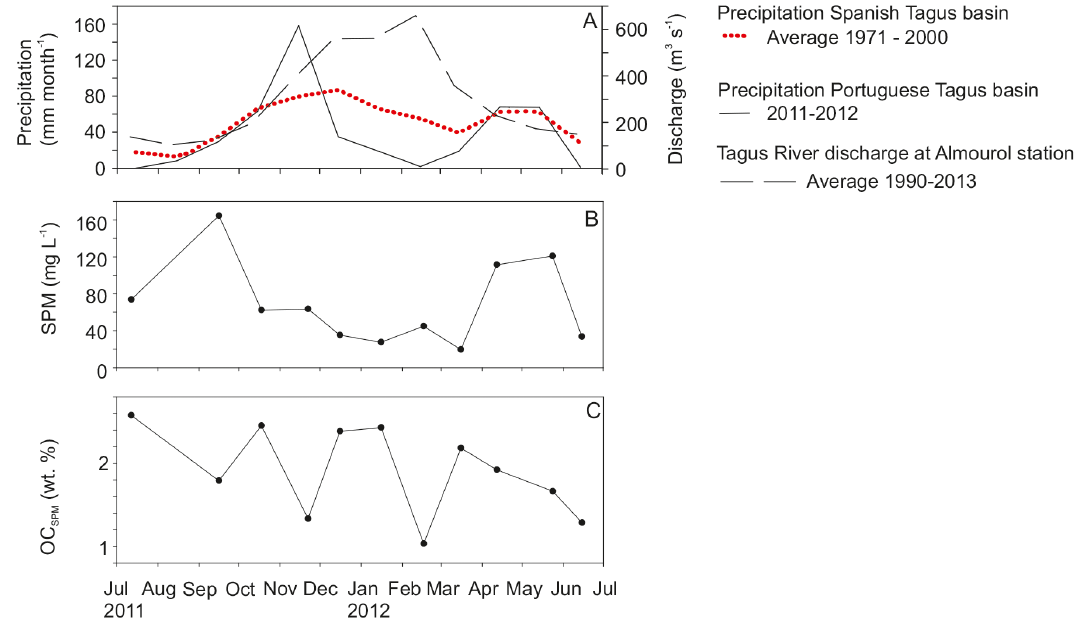
Figure 5. Mean monthly precipitation in the Portuguese and Spanish parts of the Tagus River basin and the Tagus River discharge at Almourol station (data source: Sistema Nacional de Informaçião de Recursos Hídricos) (a) , SPM concentration at the Tagus River station (b) , and the amount of OC in the SPM (wt%) of the Tagus River (c)